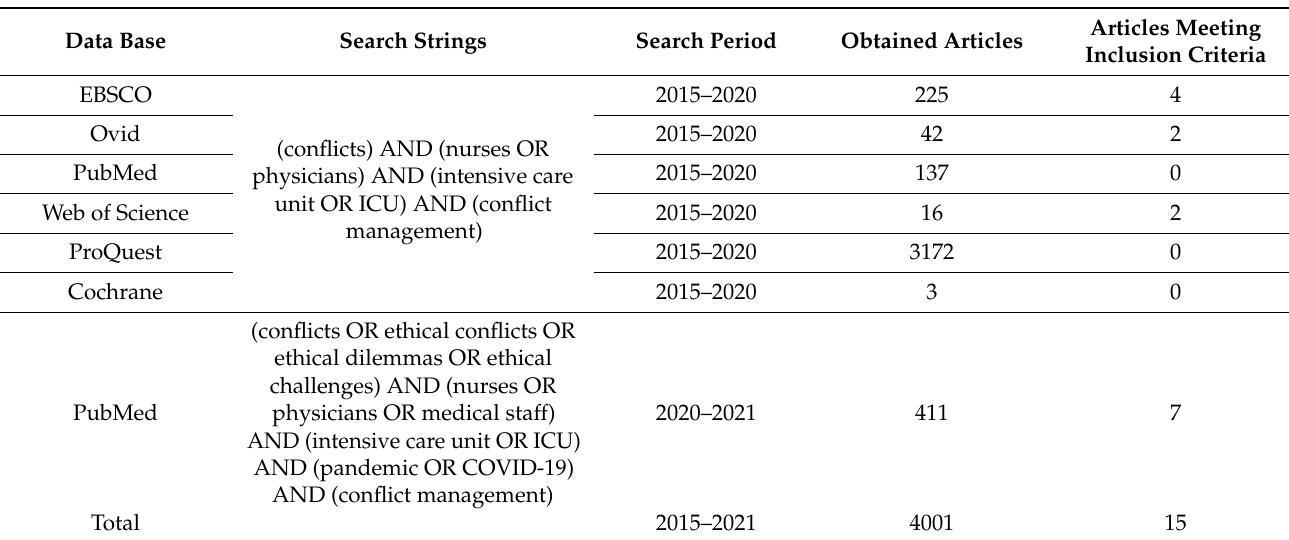
Table 1. Search strategy.